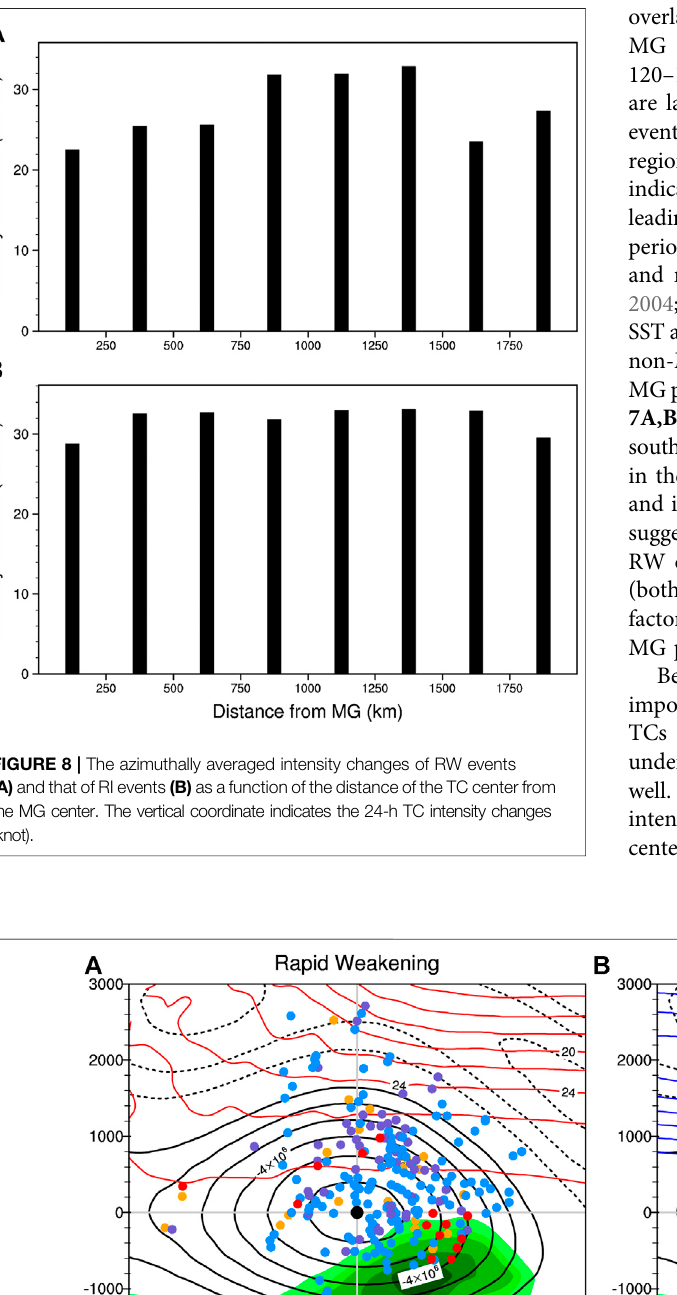
Frontiers in Earth Science |